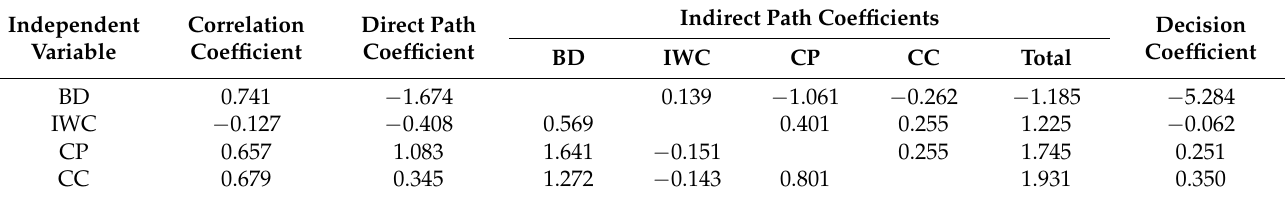
Table 7. Path coefficient between environmental factors and soil